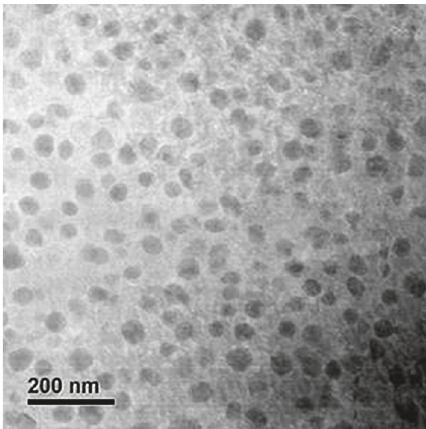
Figure 9: Transmission electron microscopy (TEM) image showing c particles of Haynes 282 alloy aged for 8h. ′